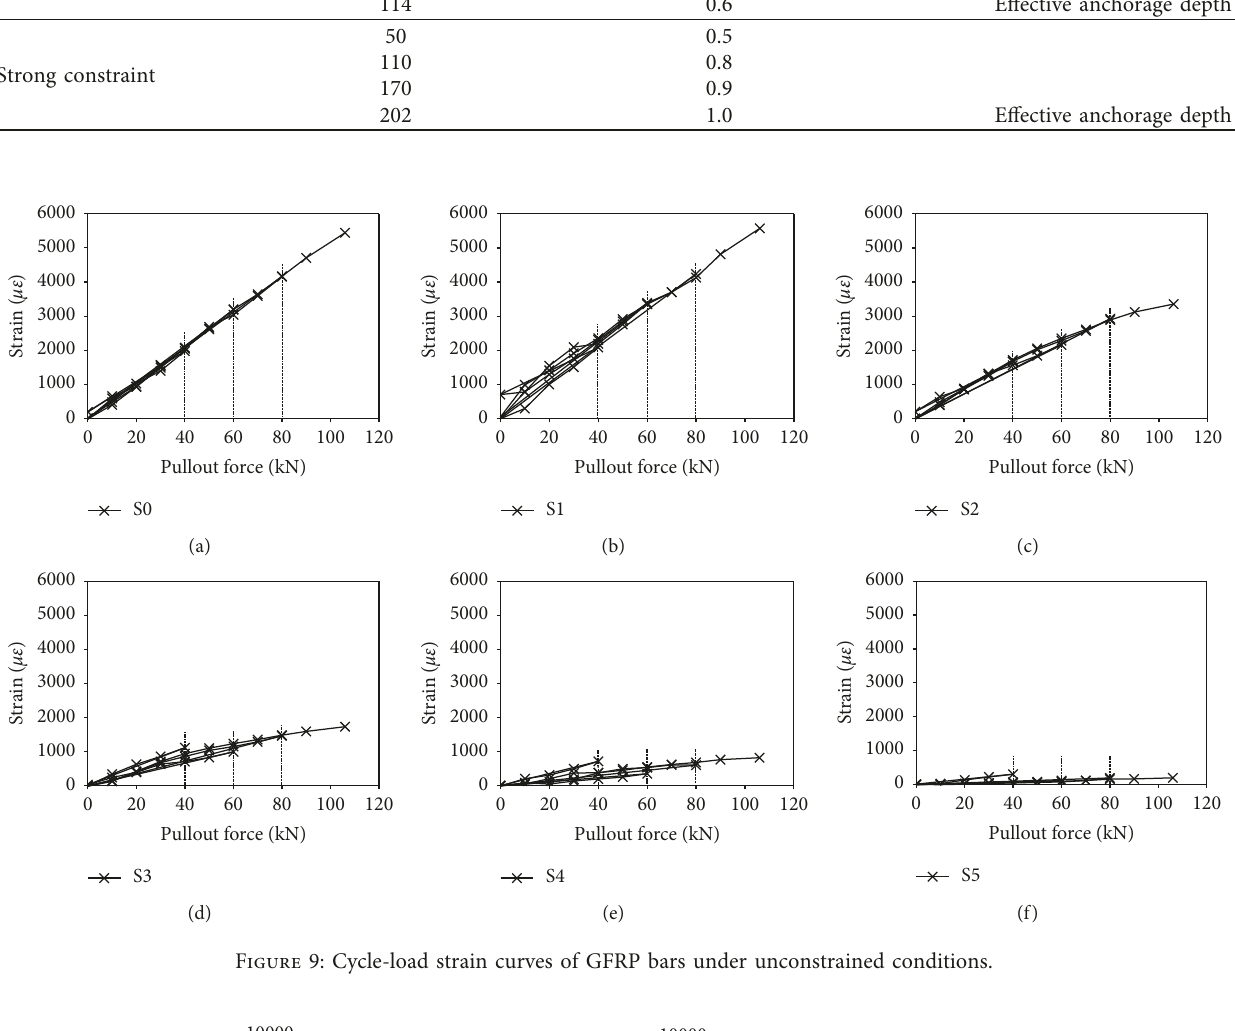
Figure 9: Cycle-load strain curves of GFRP bars under unconstrained conditions.